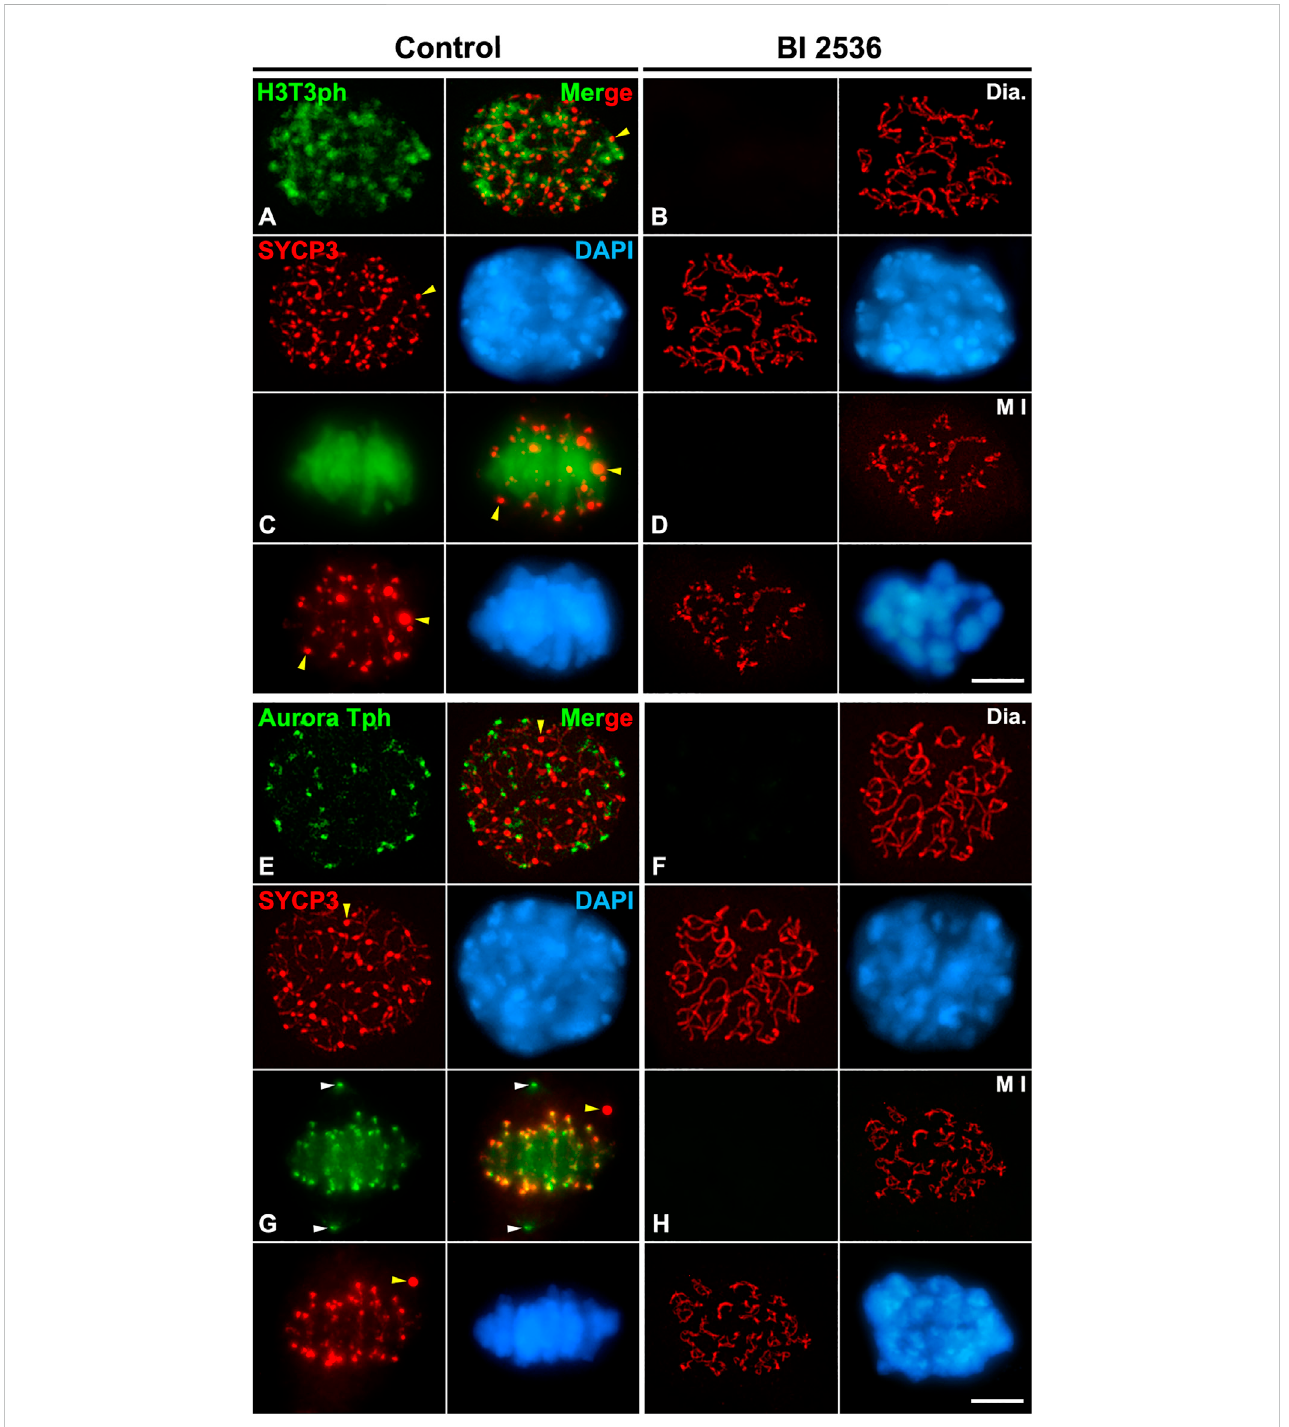
FIGURE 8 PLK1 regulates the H3T3ph-dependent phosphorylation of Aurora B/C at the inner centromeres. Double immunolabelings of SYCP3 (red) with either H3T3ph(greenin A – D )orAuroraTph(greenin E – H ),andcounterstainingofthechromatinwithDAPI(blue)onsquasheddiakinesis(Dia.) (A,E) andmetaphaseI (M I) (C,G) control spermatocytes, and diakinesis (B,F) and metaphase I (D,H) BI 2536-treated spermatocytes. Yellow arrowheads indicate SYCP3 agglomerates in the nucleoplasm and cytoplasm of control diakinesis and metaphase I spermatocytes, respectively. White arrowheads in (G) indicate the centrosomes. Scale bar represents 5 μ